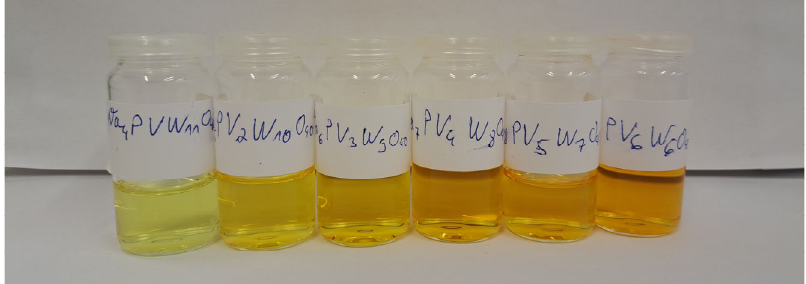
Figure 12. Solutions (1 g/L) of the different V(V) ‐ substituted tungstates, with increasing degree of substitution from left to right, x = 1–6.